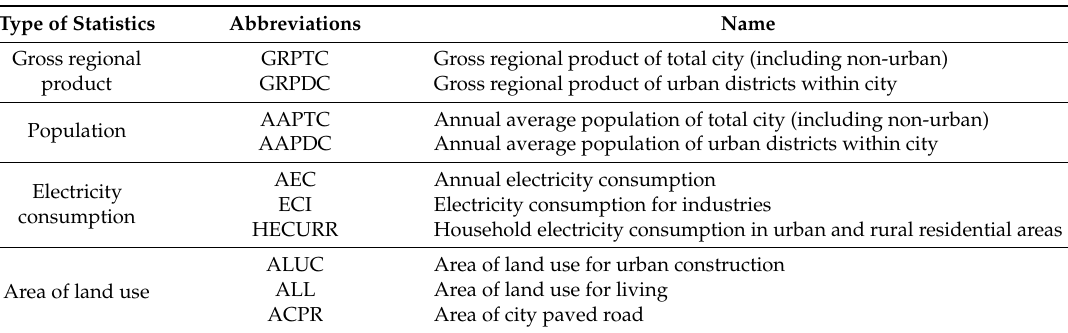
Table 2. Classification of statistical parameters.